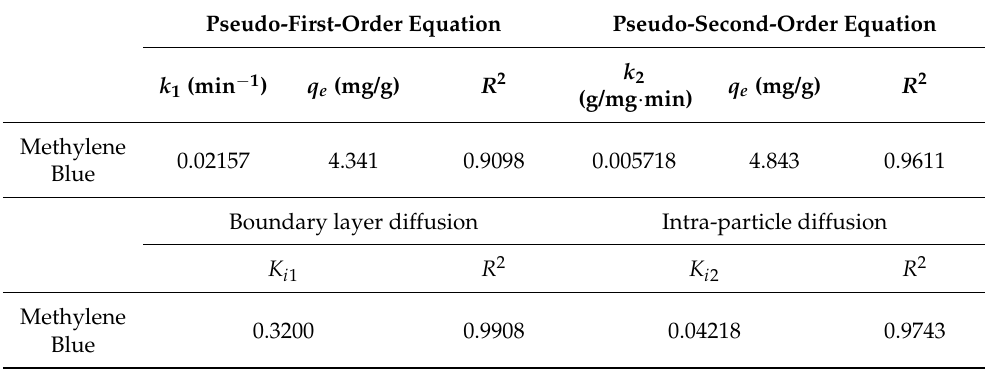
Table 1. Parameters of the pseudo-first-order, pseudo-second-order, and intra-particle diffusion models for MB adsorption on a GO/PLA filter.